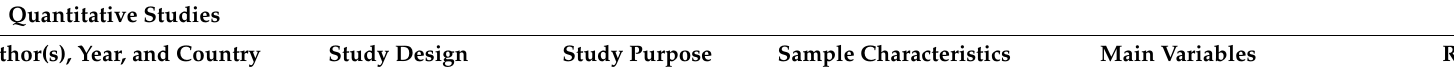
Table 3. Characteristics of the studies showing: perspective, training, and humanization of